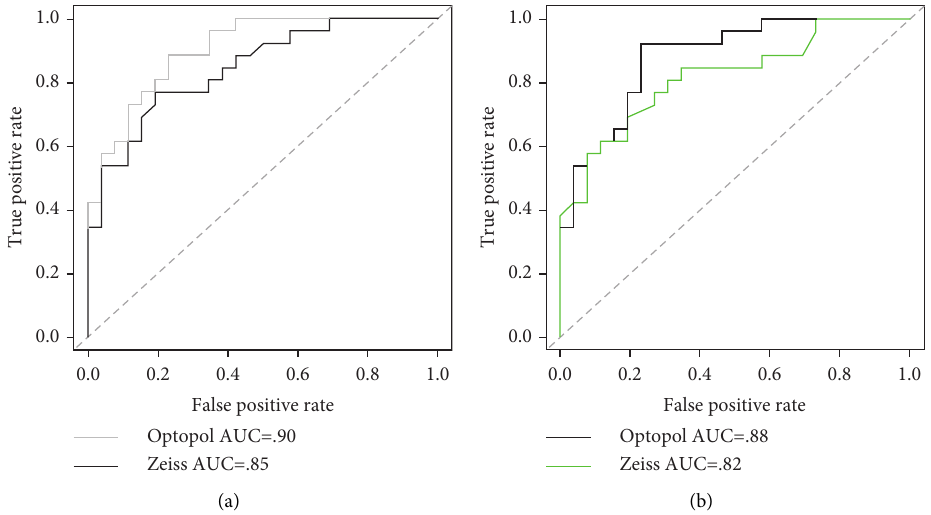
Figure 5: Receiver operating characteristic (ROC) curves for MD/PSD. ROC curves distinguishing between control and glaucomatous subjects based on MD (a) and PSD (b) indices from ZETA Fast (Optopol) vs. SITA Fast